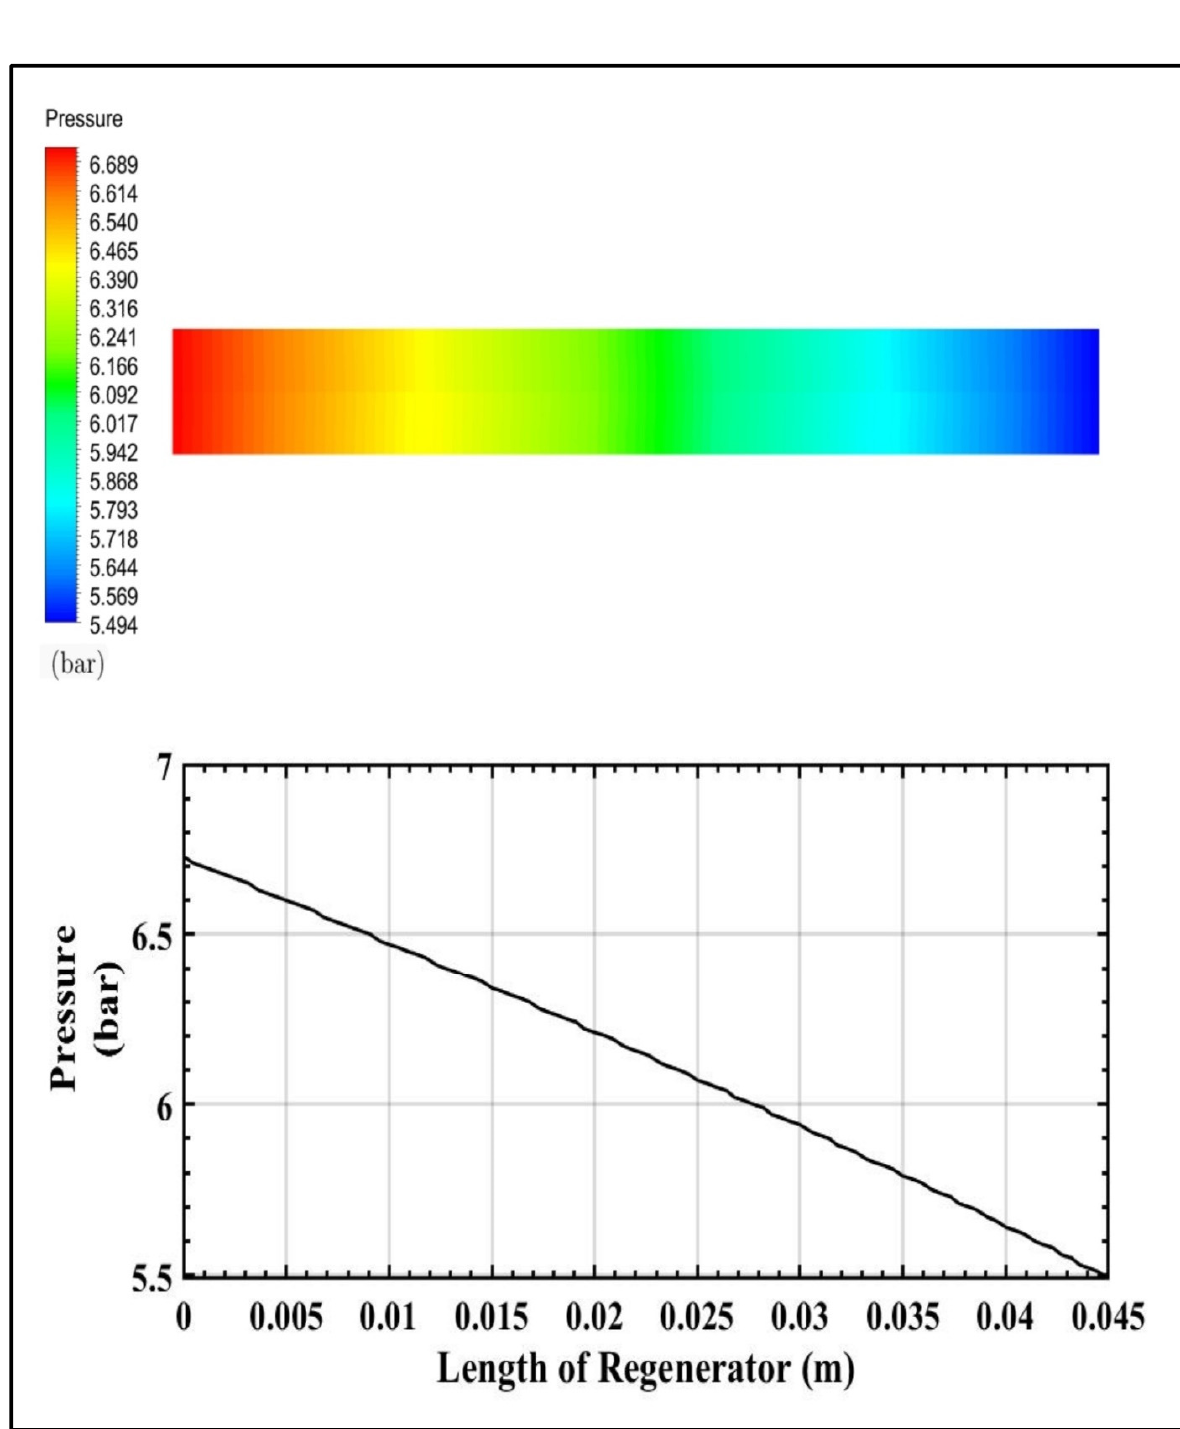
Figure 25. Variation of pressure along the length of the 200 mesh regenerator at 0.5 s.